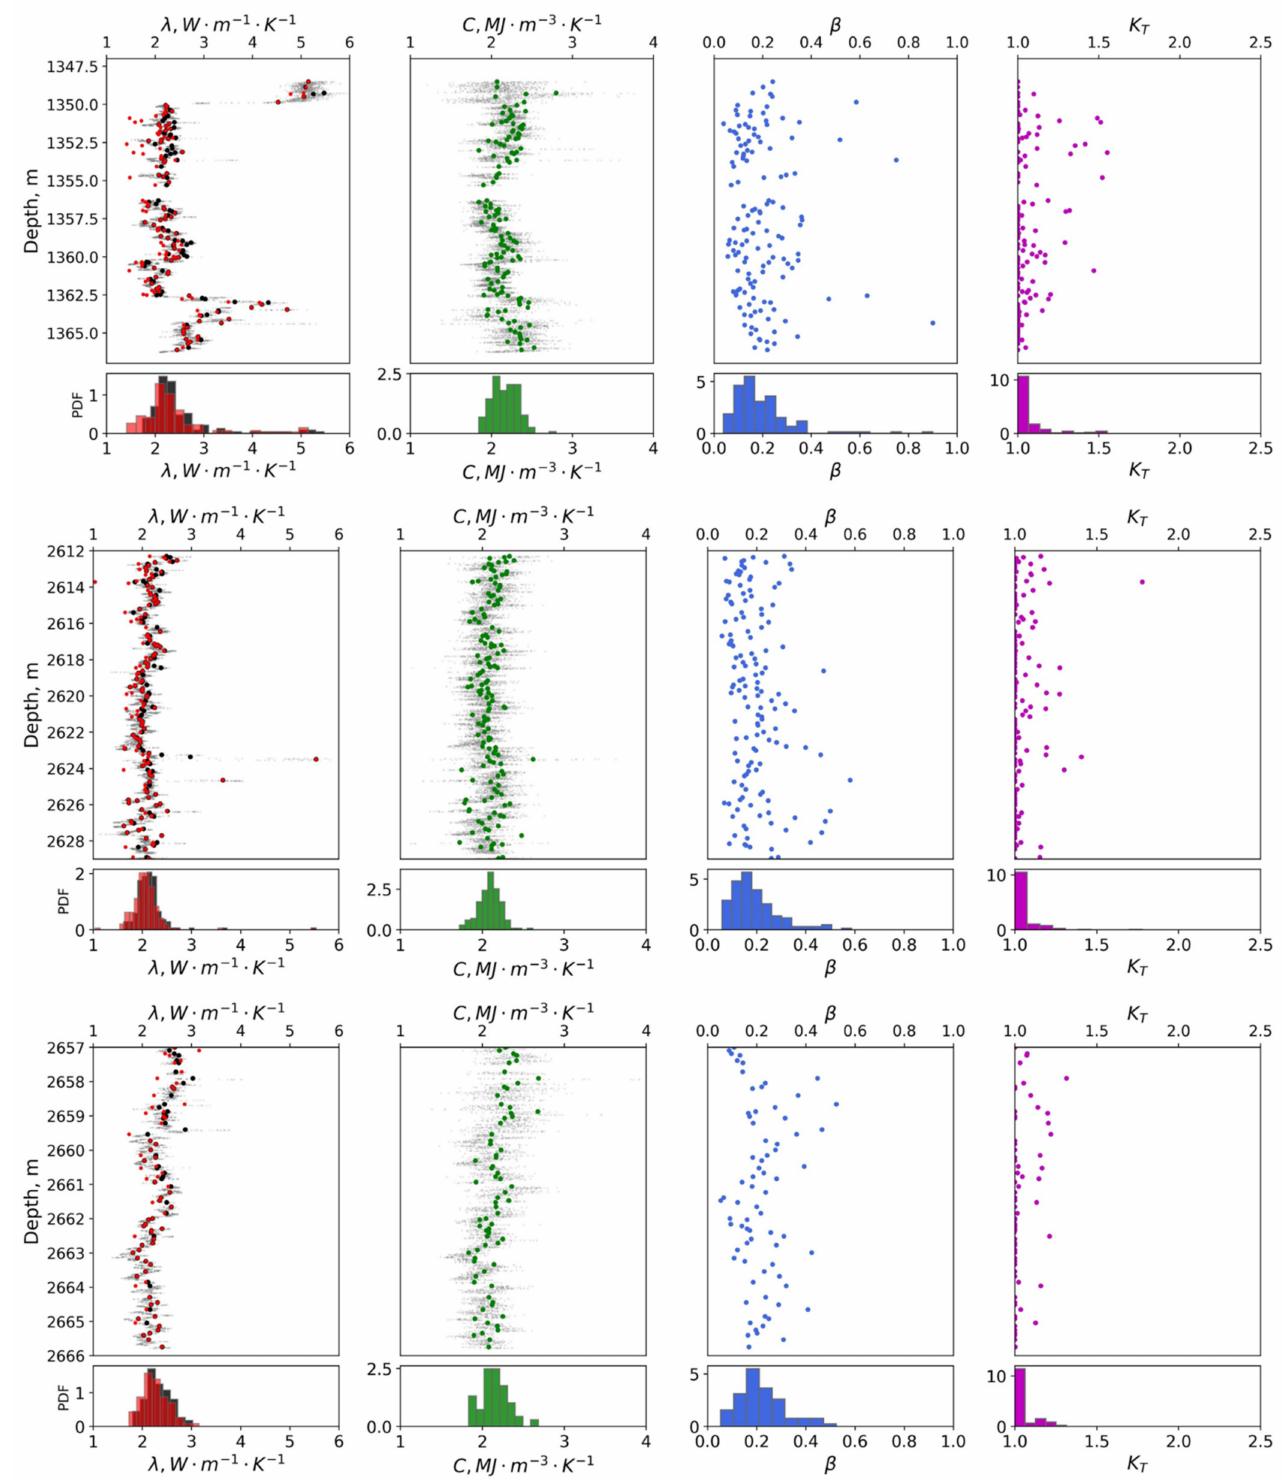
Figure 6. Results of continuous thermal core logging for depth intervals of 1348.5–1366.1 m ( upper panel), 2612.29–2629.2 m ( middle panel), and 2657.00–2665.74 m ( lower panel). Black dots represent thermal conductivity parallel to the bedding plane, red dots show the thermal conductivity perpendicular to the bedding plane, green dots show the volumetric heat capacity, blue dots show the thermal heterogeneity factor, and purple dots represent the thermal anisotropy coefficient. Grey dots represent profiles with a 1 mm spatial resolution of thermal conductivity and volumetric heat capacity. Colored dots represent core scale